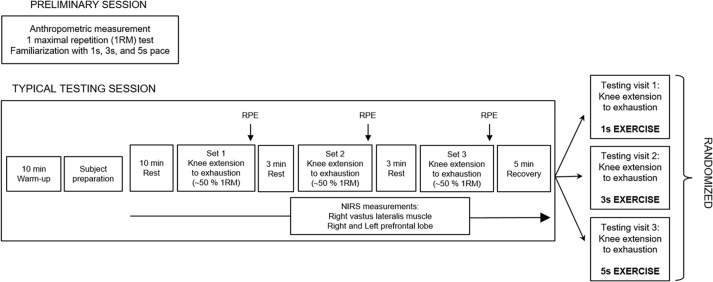
Schematic representation of the experimental design.The preliminary session and each testing session were performed in separate days. 1 s exercise, 1 s concentric and 1 s eccentric phase. 3 s exercise, 3 s concentric and 3 s eccentric phase. 5 s exercise, 5 s concentric and 5 s eccentric phase.